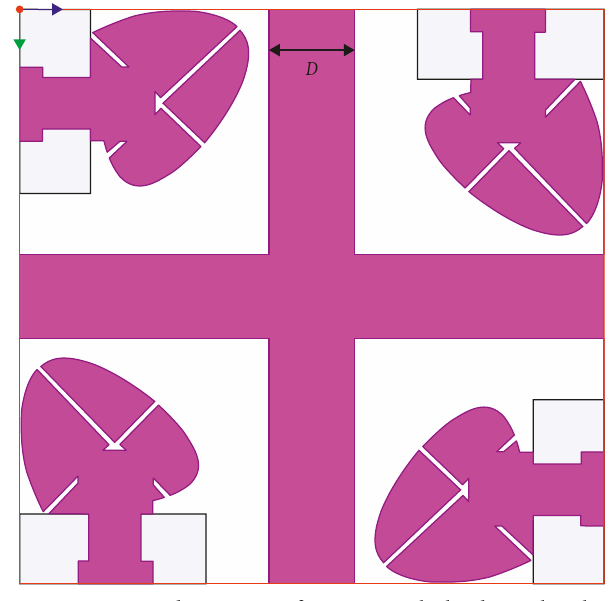
Figure 11: Proposed MIMO configuration with the decoupling